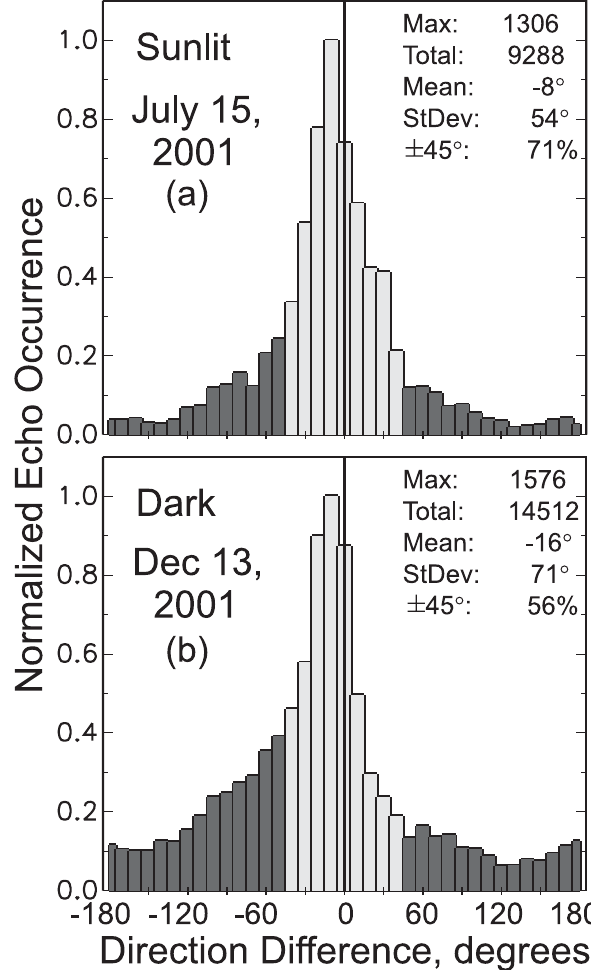
Fig. 5. The same as in Fig. 4 but for 15 July 2001 and 13 December